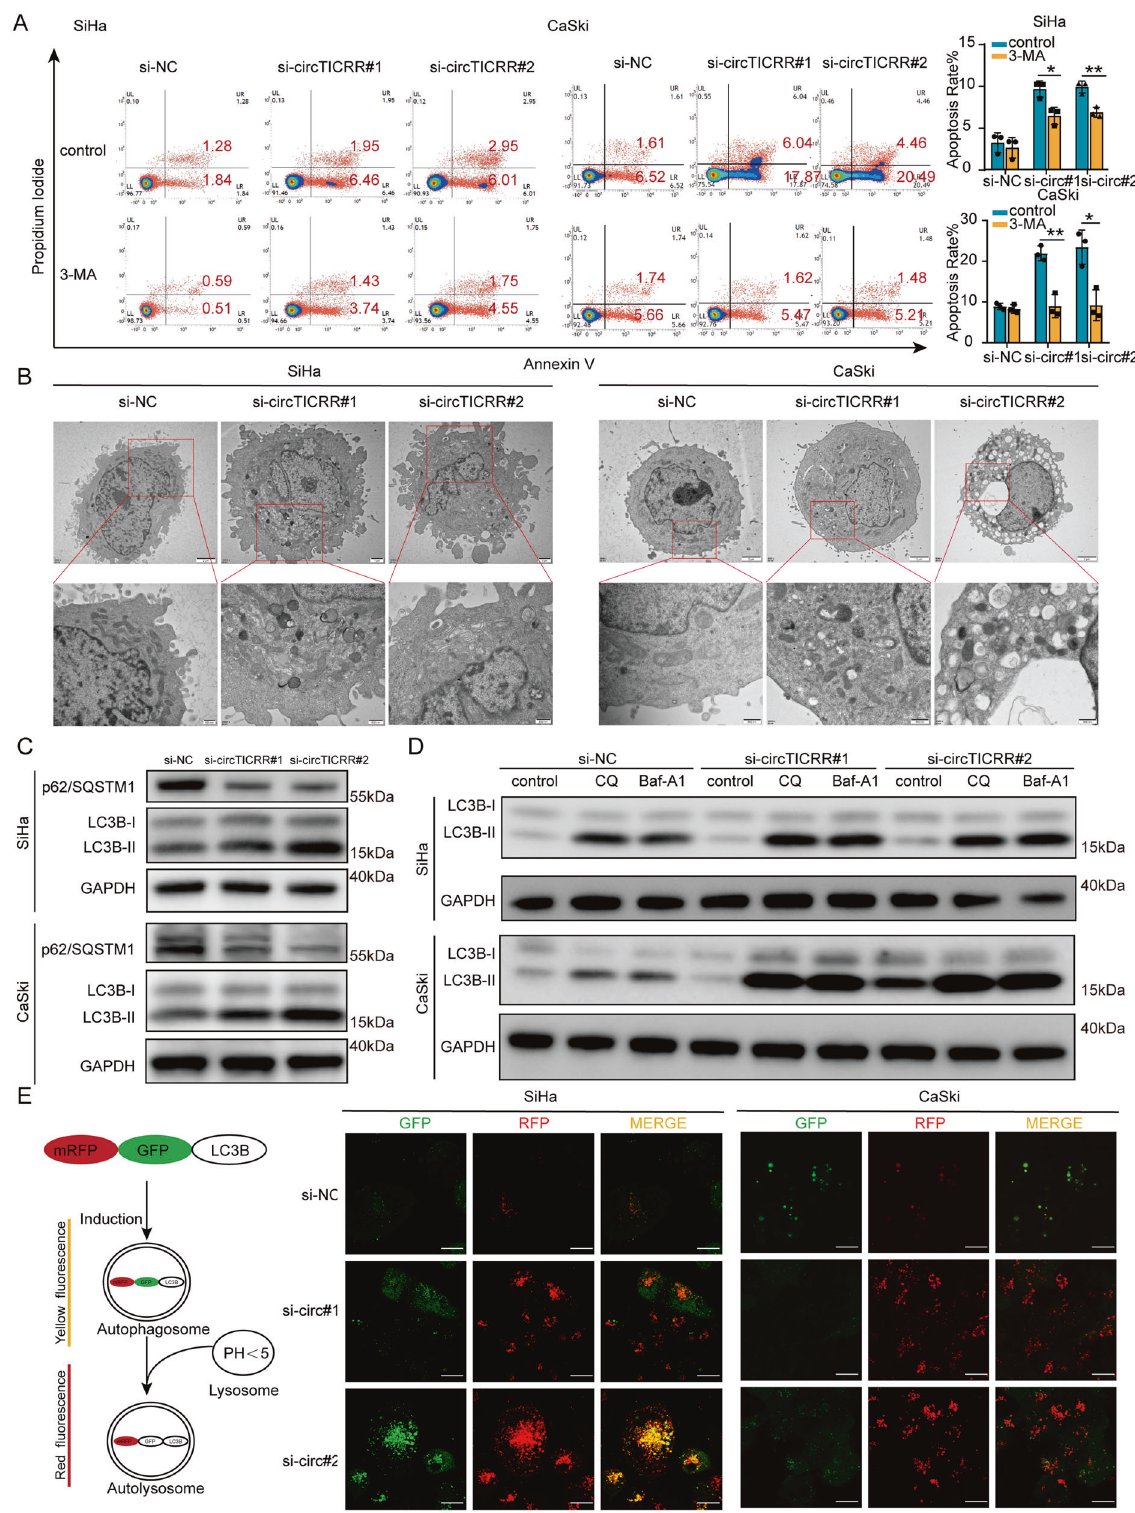
Fig. 3 CircTICRR knockdown promotes apoptosis via inducing autophagy in cervical cancer cells. A Apoptosis in SiHa and CaSki cells was analyzed by Flow Cytometry. Cells were treated with autophagy inhibitor (3-MA) or normal medium for 1 h, then combined treated with siRNAs for additional 72 h. Cell morphology ( B ) and autophagy-related proteins ( C ) were monitored by TEM and western blot, respectively. D SiHa and CaSki cells transfected with siRNAs or negative control for 72 h were treated with the autophagy inhibitor CQ or Baf-A1 for another 6 h. Then, the autophagy-related protein LC3BI/II was monitored by western blotting. E Left panel: Schematic diagram illustrating the mechanism of mRFP-GFP-LC3B. Right panel: SiHa and CaSki cells transfected with mRFP-GFP-LC3B for 24 h were transfected with si-NC, si- circTICRR#1 and #2, respectively, for another 48 h. Images were captured by confocal microscopy. Scale bar, 30 μ m. Data are representative of at least three independent experiments and presented as the mean ± SD. * p < 0.05, ** p < 0.01, *** p < 0.001. Cell Death and Disease (2022)